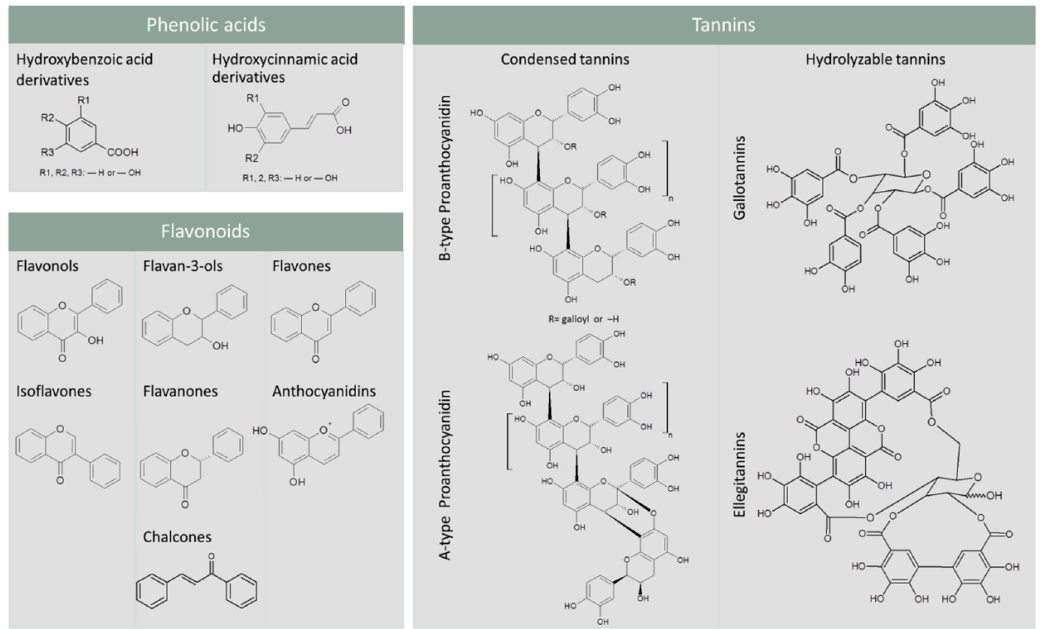
Figure 1. Skeleton structure of the main dietary phenolic compounds.